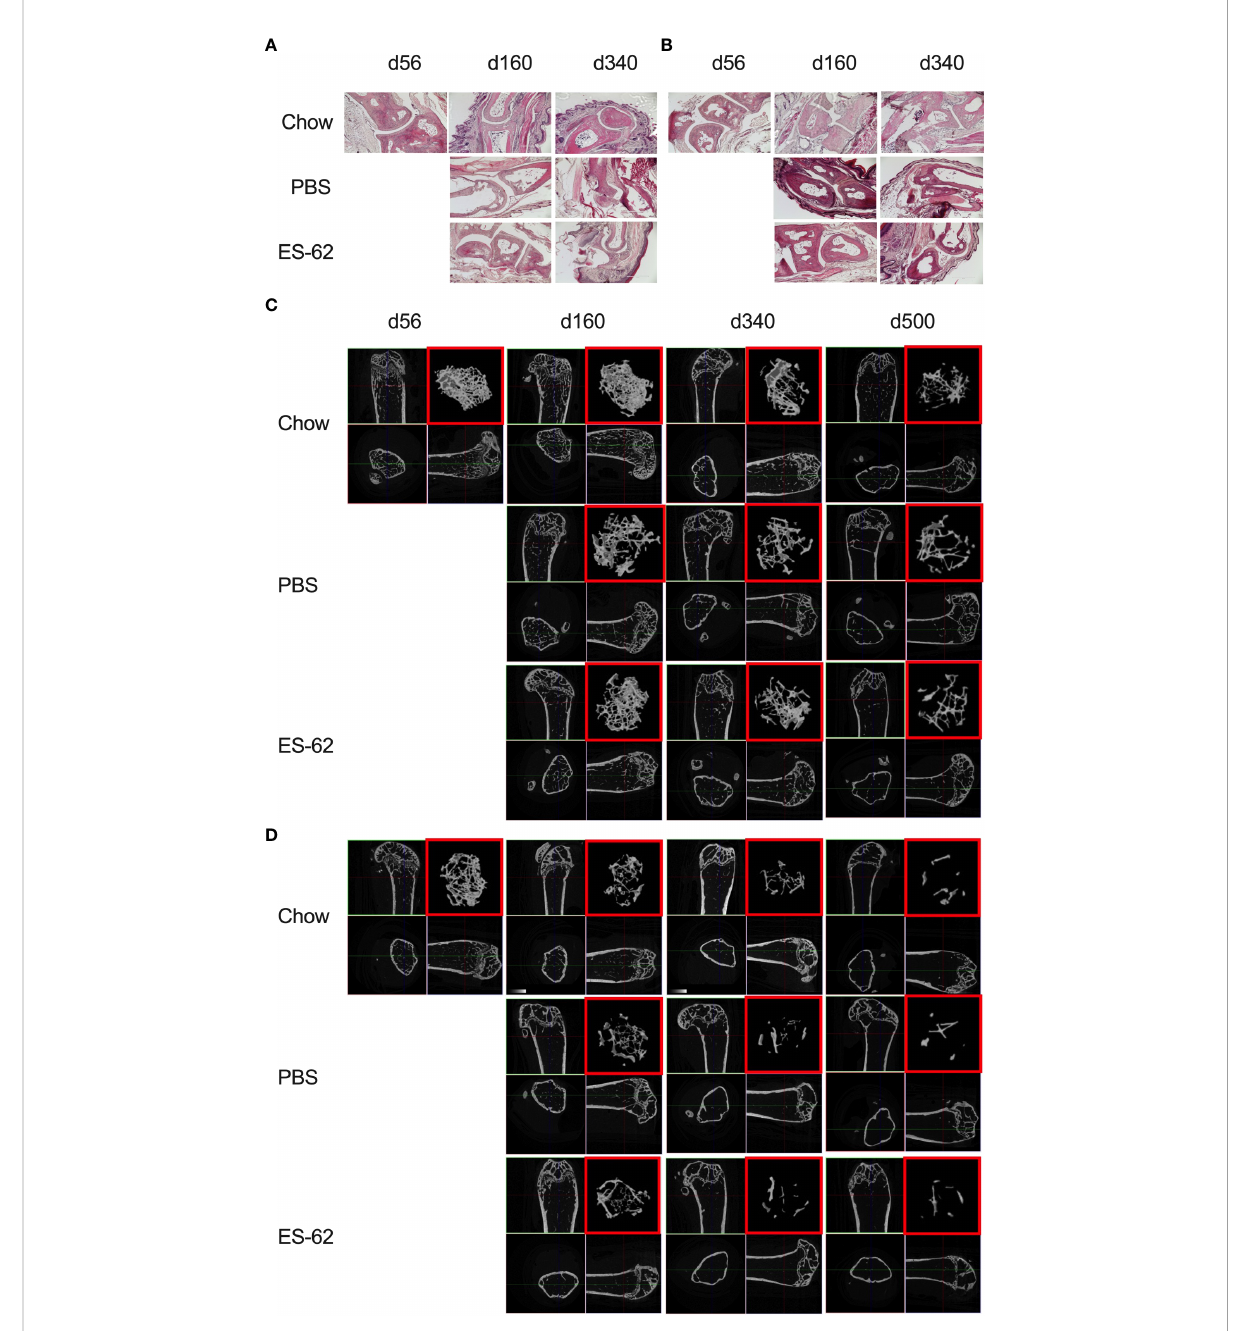
FIGURE 2 Impact of HCD-feeding and exposure to ES-62 on trabecular bone structure. Representative sections of H & E staining of paw joint sections (scale bar 400 µm) are shown for the indicated groups of male (A) and female (B) mice and where tissue damage was not signi fi cantly different across the groups. Scores: for male mice, d56: 0, n=3, Chow: 0.48 ± 0.09, n=11; PBS-HCD: 0.58 ± 0.08, n=4; ES-62: 0.25 ± 0.08, n=4; for female mice, d56: 0.11 ± 0.11, n=3; Chow: 0.50 ± 0.14, n=10; PBS-HCD: 0.66 ± 0.24, n=4; ES-62: 0.44 ± 0.22, n=3. MicroCT analysis of femurs from the indicated groups of male (C) and female (D) mice was performed and representative 2D images of transverse sections through femurs illustrating the reference growth plate and the downstream area (~200 slices of pixel size 5 µm) of analysis of trabecular parameters (upper left and lower right boxes) are shown. Reconstruction of the image stack provided 3D images of the trabecular structure (red box) whilst cross- sectional analysis provides a 2D image of the cortical bone (lower left